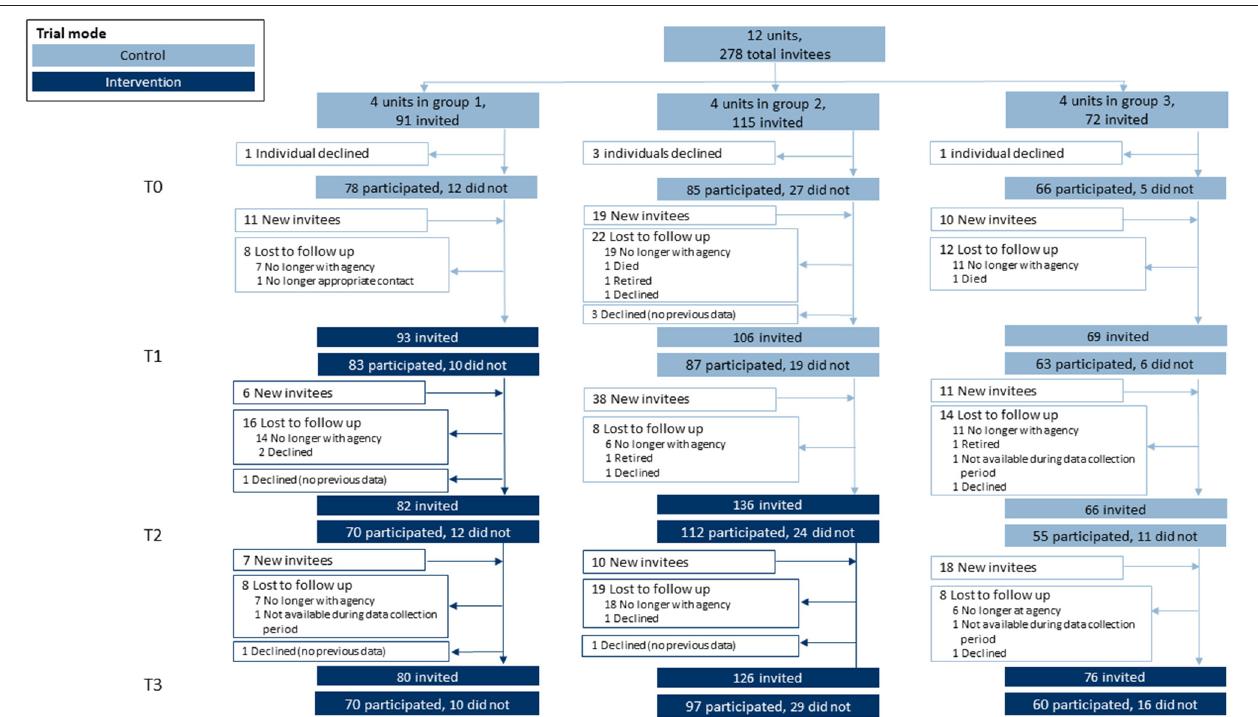
FIGURE 2 | Participation flow diagram. This stepped-wedge design featured 12 units (local health departments) randomly assigned into one of three groups. Within each unit, individuals were invited to participate in a quantitative survey at four separate time points. Each time point included returning survey invitees and newly-invited individuals (open cohort design) where turnover warranted replacements with new hires.